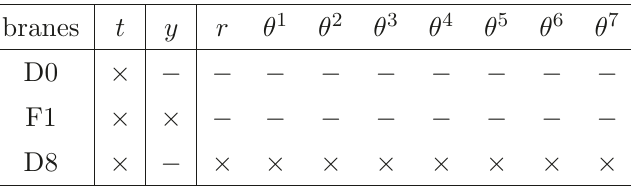
Table 1 . The brane picture underlying the scribed by a D0-F1-D8 system. The above system is 1 realizing the dual AdS 2 geometry turns out to be a combination of y & r